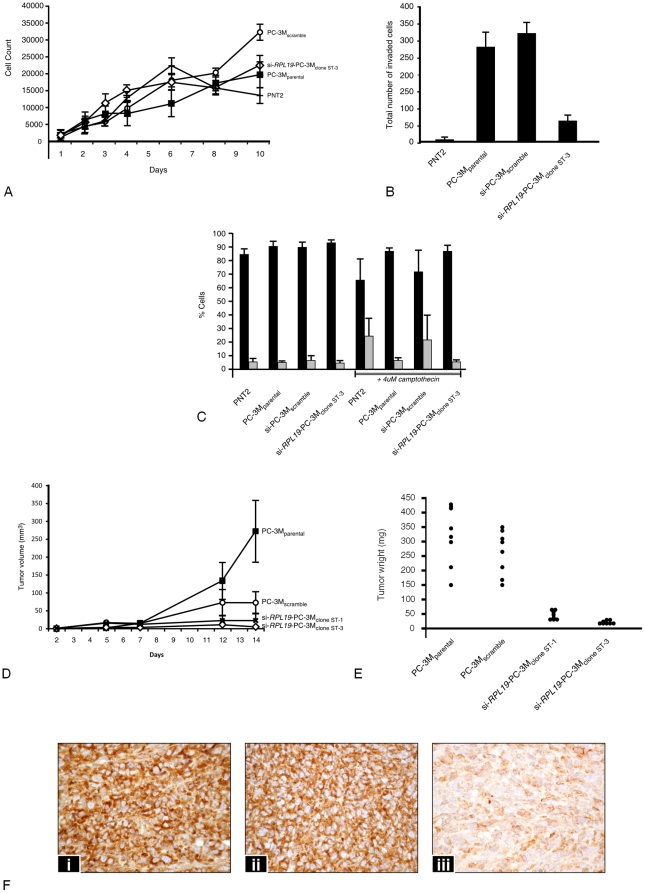
Growth characteristics of si-PC-3Mclone ST-3 cells in-vitro and in-vivo.A. Relative growth of cell-lines in monolayer culture revealing no statistical difference in the rate of proliferation between the knockdown cells (si-RPL19-PC-3Mclone ST-3) and that of PC-3Mparental cells. B. Invasion assay in-vitro comparing the same populations of cells as those shown in (A) and revealing an 83% decline in the invasive capacity of the RPL19 knockdown cells relative to PC-3Mscramble cells. C. Resting levels of apoptotic indices were not significantly different in the benign (PNT2), parental (PC-3M) or knockdown cells. After challenge by camptothecin, no change was identified in the PC-3Mparental or si-RPL19-PC-3Mclone ST-3 cells. While an increase in apoptosis was found in the benign cells and in the scramble-transfected cells, these were not significant. D. Growth of tumor cells in-vivo by estimated volume revealed a highly significant (p<0.005) suppression of growth by two of the stable transfectant clones, when compared to the PC-3Mparental and PC-3Mscramble cells. Growth of PNT2 cells is not included since we have already shown [33] the growth of tumors to be infrequent, particularly over the time-span of these experiments. E. Analysis of tumor weights in-vivo confirmed clones ST-1 and ST-3 to generate tumors significantly (p<0.005) smaller than the PC-3Mparental or the si-PC-3Mscramble cells. F. Immunohistochemical analysis of tumors growing as xenografts in-vivo supported the mRNA levels data (Figure 1B) that whereas the original PC-3Mparental (i) and si-PC-3Mscramble (ii) cells expressed RPL19 protein at high level. The si-RPL19-PC-3Mclone ST-3 cells (iii) expressed RPL19 heterogeneously and at only very low levels. (Magnification ×350)